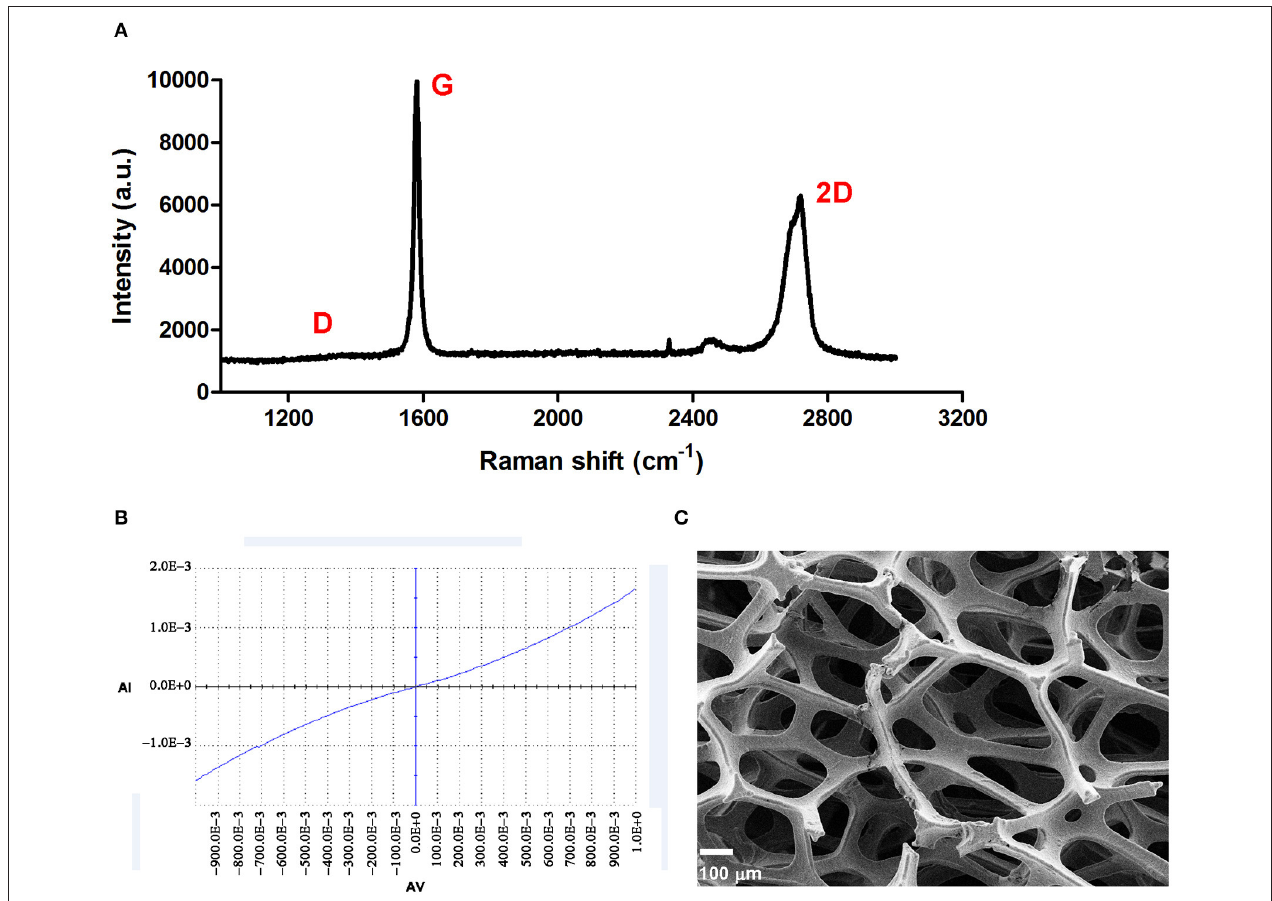
FIGURE 1 | Characterization of 3DG. (A) Typical Raman spectrum of 3DG. (B) Current curve of 3DG. (C) SEM micrograph of 3DG. Scale bar = 100 µ m.